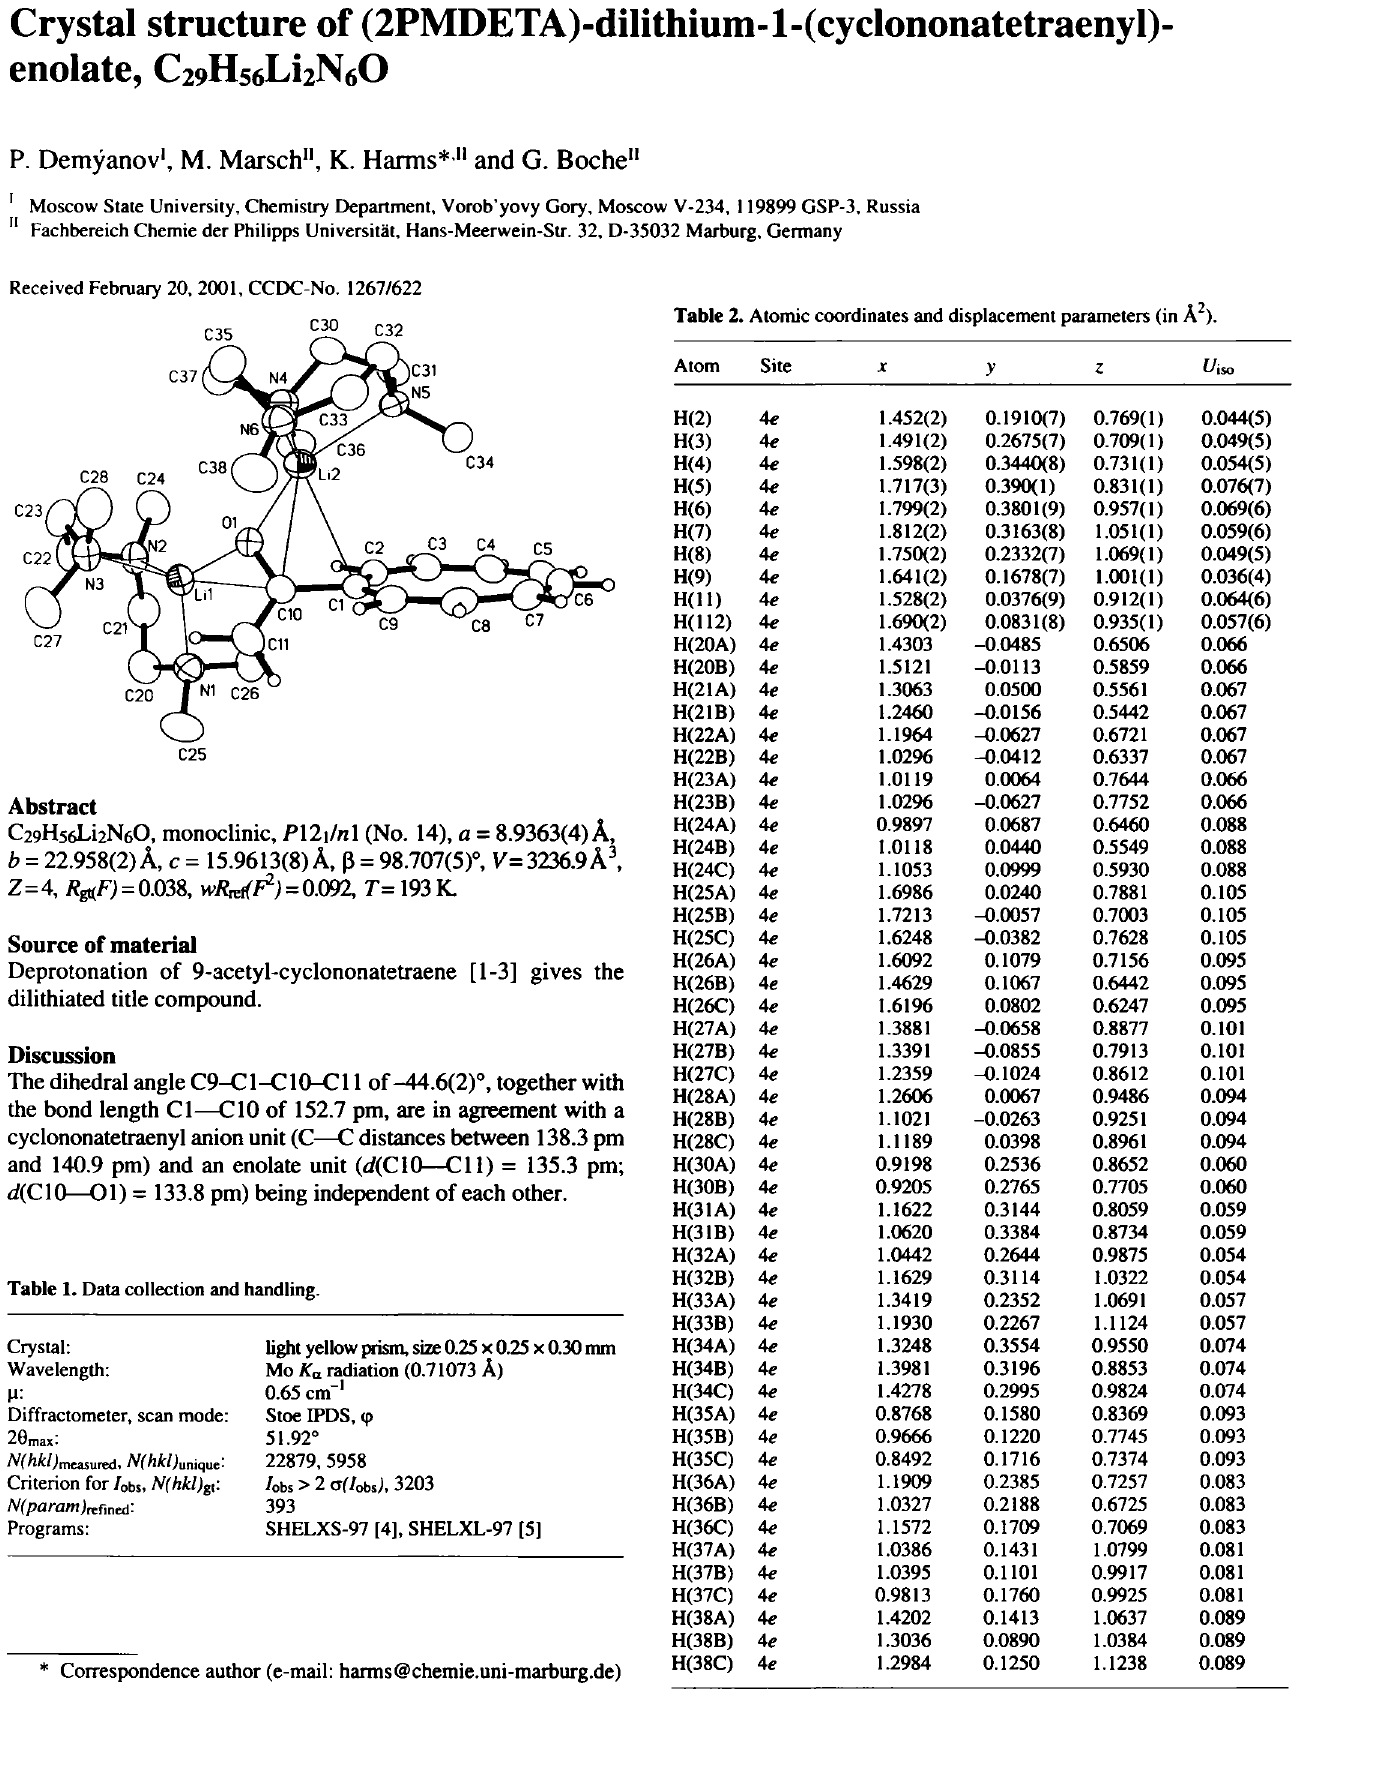
Table 1. Data collection and